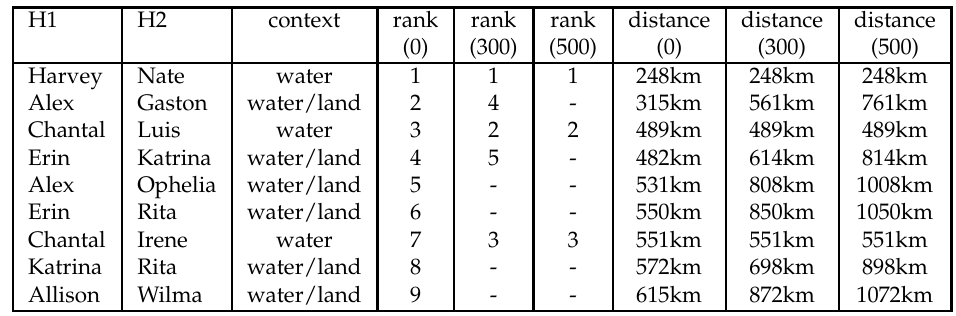
Table 1: The context-aware Fr´echet distances and ranks of the nine spatially closest pairs of hurricanes for three different context